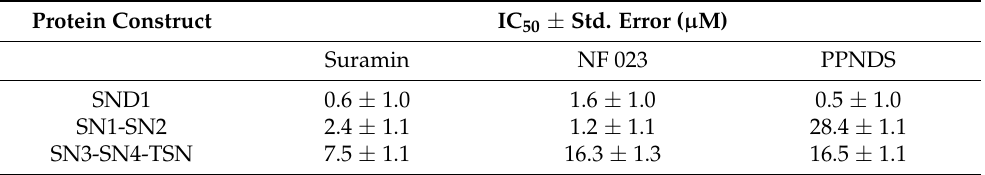
Table 1. Potencies of the hit compounds.